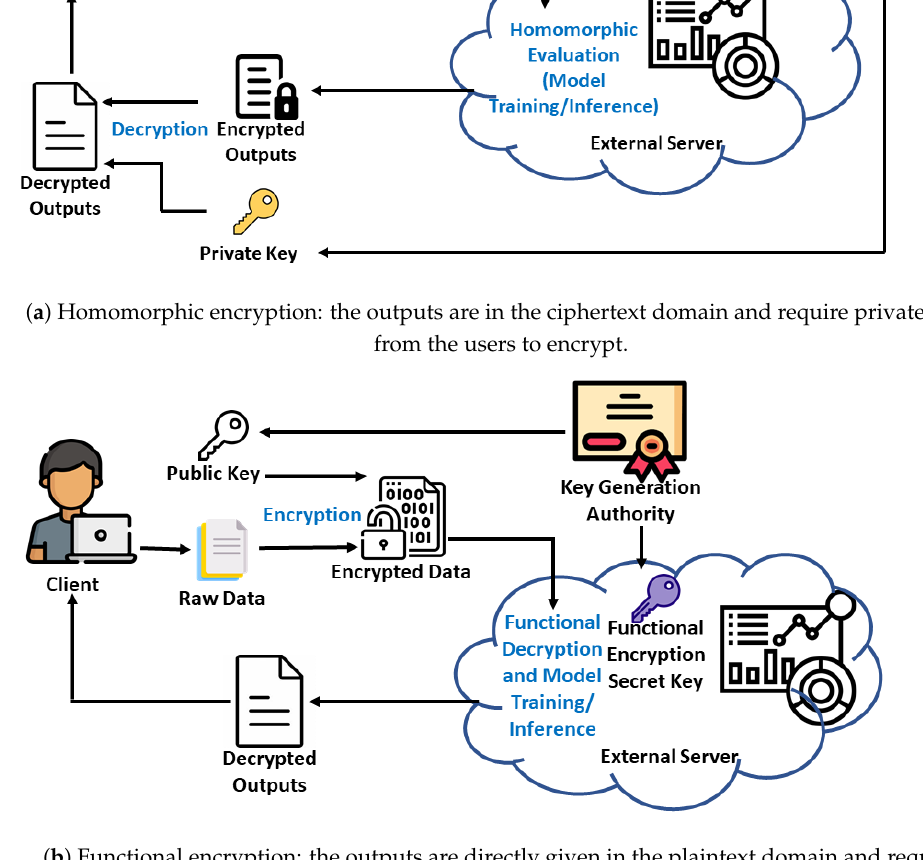
Figure 11. Illustration of homomorphic ( a ) and functional ( b ) encryption for deep learning model training/inference on remote